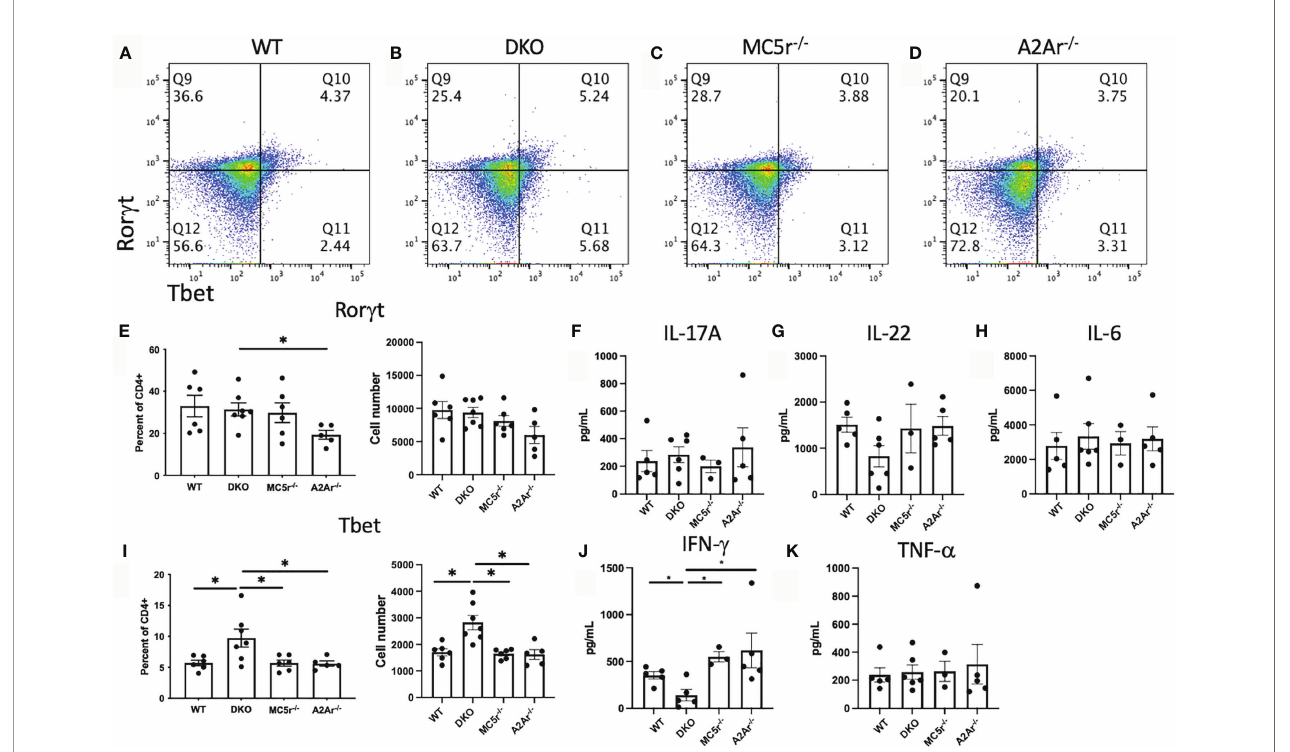
FIGURE 5 | T cell response at the onset of EAU in WT, MC5r -/- , A2Ar -/- , and DKO mice. Spleens from WT (n = 4-6), DKO (n = 6-7), MC5r-/- (n = 3-6) and A2Ar -/- (n = 5) were collected, restimulated with IRBP, and assayed for Treg, Th17, and Th1 pro fi les from at the onset (day 24) of disease. Representative pseudocolor fl ow cytometry dot plots are shown for Rorgt and Tbet expression from the spleen (A – D) with the mean ± SEM for all mice. The mean ± SEM is shown for Rorgt (E) IL-17A (F) , IL-22 (G) , IL-6 (H) , Tbet (I) , IFN-g (J) , and TNF-a (K) . Signi fi cance was determined by Mann-Whitney U test. Statistical signi fi cance (P ≤ 0.05) is designated by